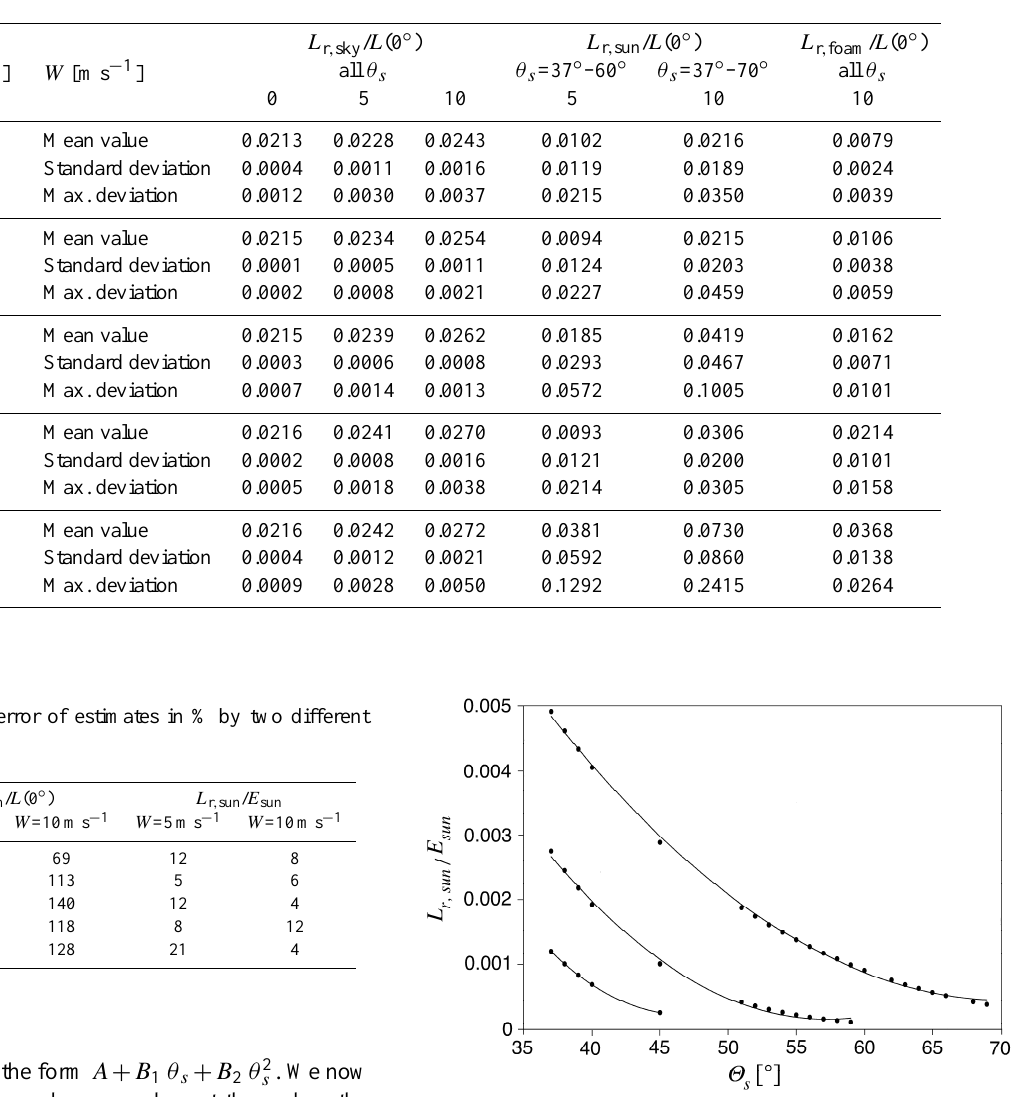
Fig. 7. The ratio L r , sun / E sun as a function of θ s , at the wavelengths 405, 450, 520, 550 and 650nm. Only ratios greater than 0.0001 are taken into account. The best-fit lines represent, from bottom to top, the wind speeds 3, 5 and 10 m s -1 , and their polynomials are presented in Table 5.